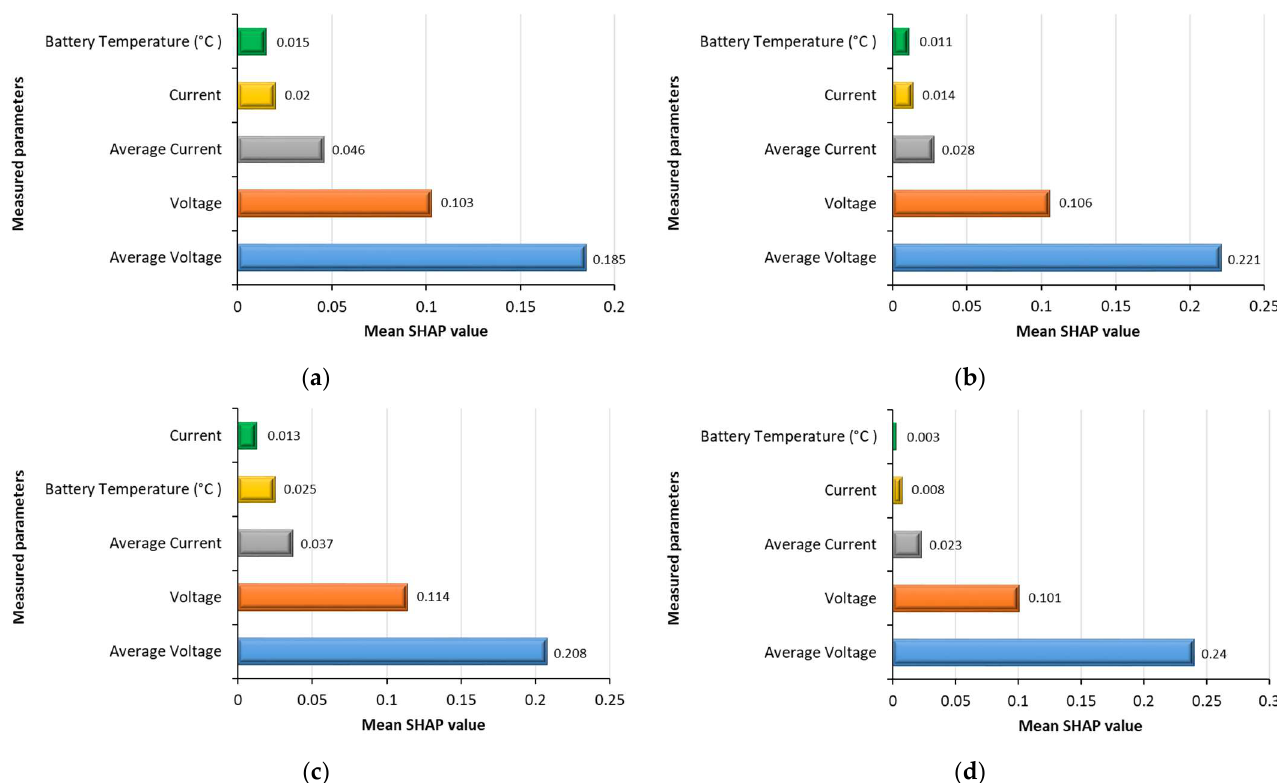
Figure 19. Feature importance of the hybrid CNN-GRU-LSTM model trained with the data of ( a ) −10 °C ( b ) 0 °C, ( c ) 10 °C and ( d ) 25 °C.